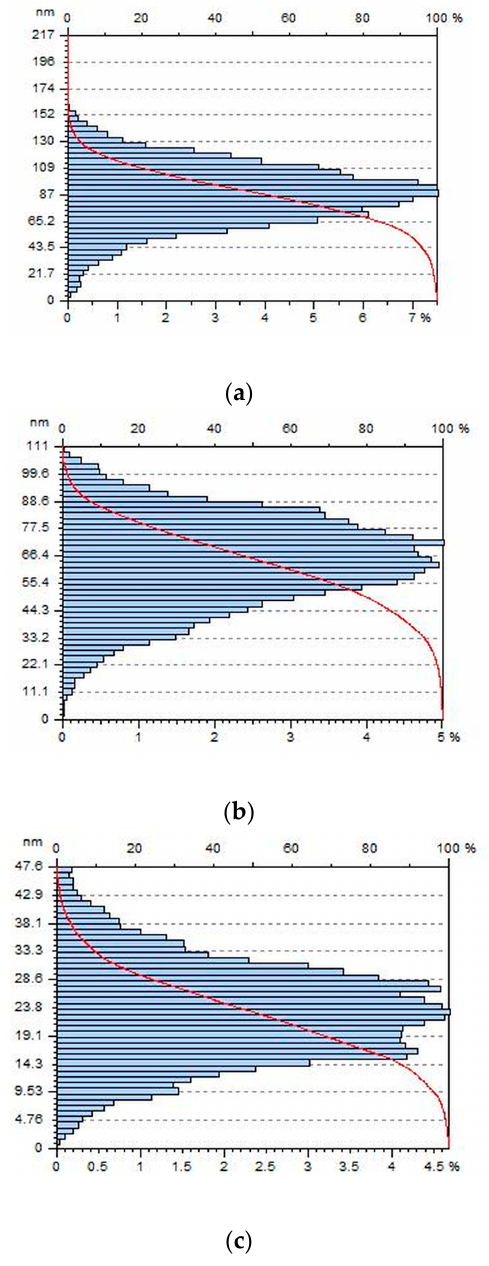
Figure 5. Particle size distribution for S1 ( a ); S2 ( b ) and S3 ( c ). Table 2. Surface particle sizes, nano-roughness and layer